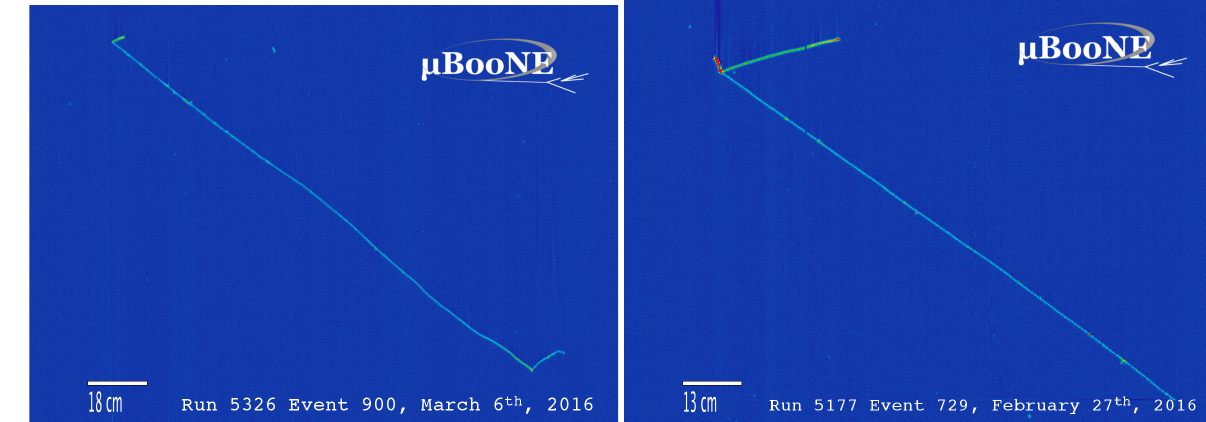
Figure 148. Event displays from the MicroBooNE liquid argon detector, showing the excellent ability to distinguish CC 0 π ( left ) and CC 1 π ± ( right ) charged-current ν µ scattering